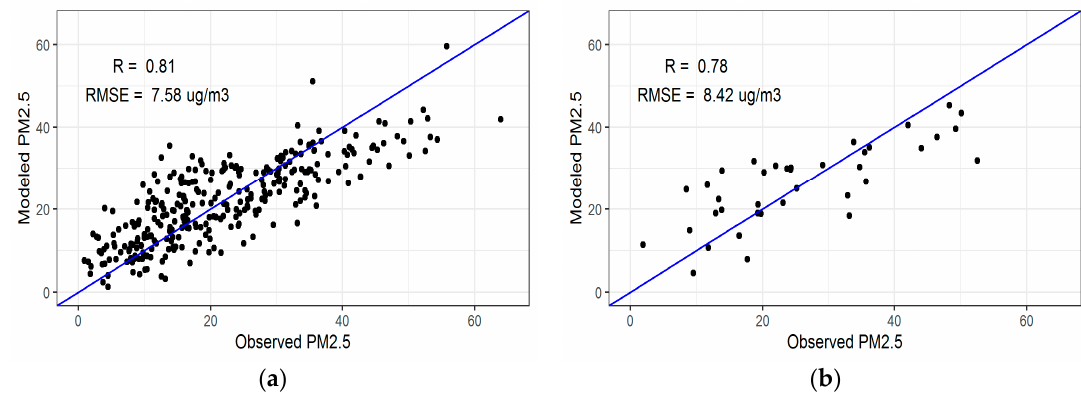
Figure 4. Correlation between the observed PM 2.5 concentrations and the modeled PM 2.5 concentrations resulted from Model 3 ( a ) calibration with AERONET datasets and ( b ) evaluation with MISR datasets. The blue line represents the 1:1 line between the observed and modeled variables. For illustration, we applied calibration Model 3 to convert all 4.4 km MISR AOD retrieved over period of the DRAGON campaign (Figure 5).